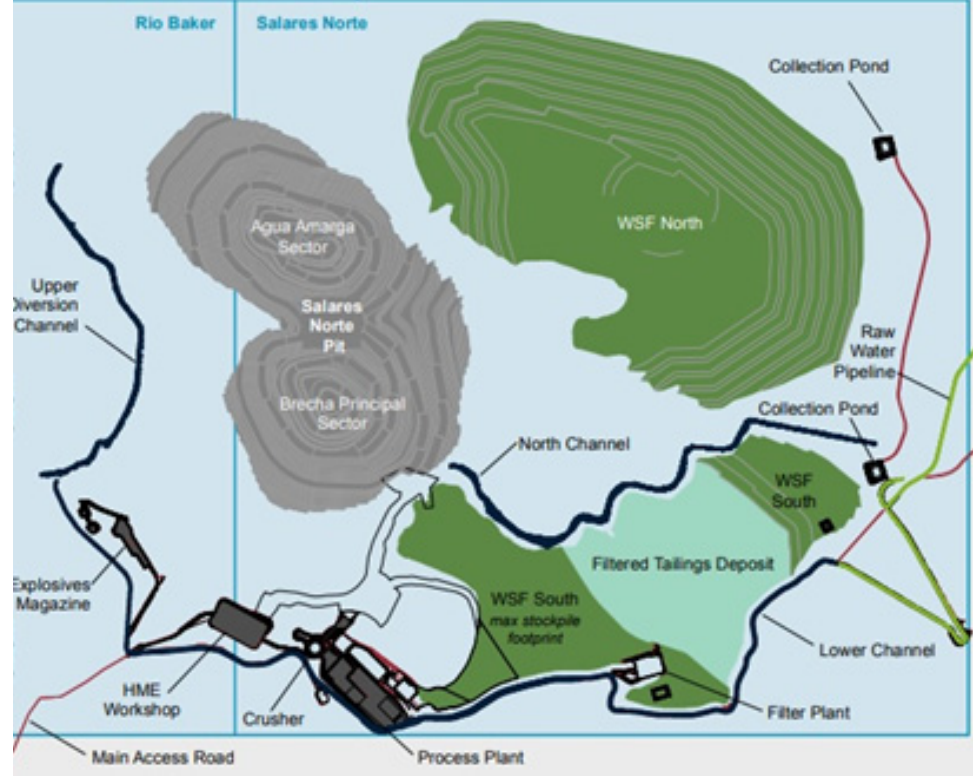
Figure 37. Salares Norte Filtered Tailings Storage Facility—Layout [50,64,65].